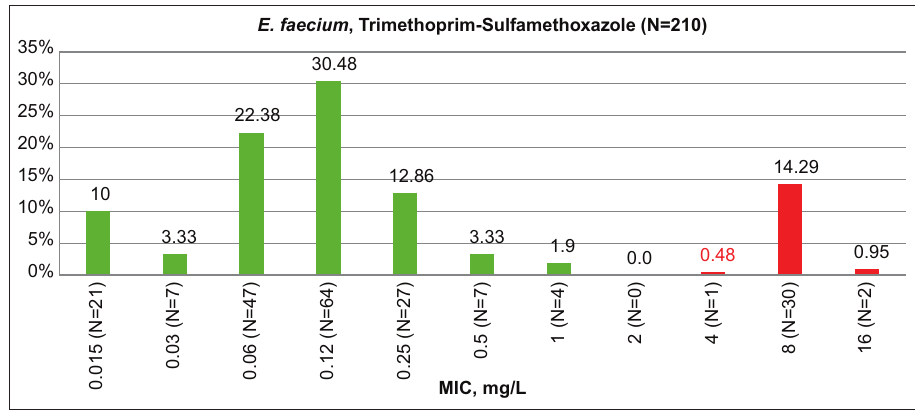
Figure-2: Trimethoprim-sulfamethoxazole minimum inhibitory concentration distribution among Enterococcus faecium isolates. Green columns – percent of susceptible isolates, red – resistant (EUCAST 2021 breakpoints), N – number of isolates.